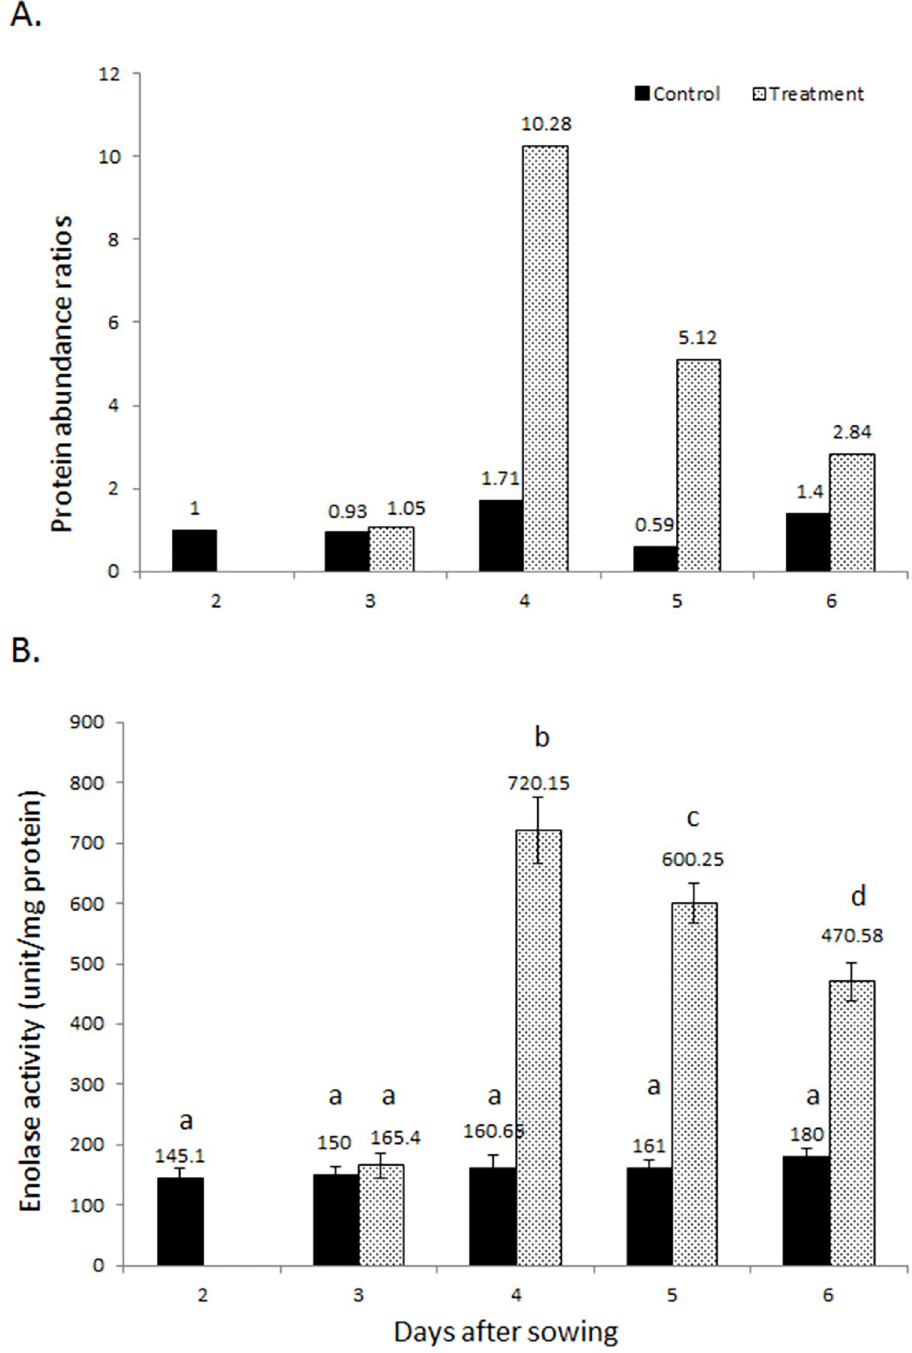
Fig 6. Changes in protein abundance (A) and enzyme activity (B) of enolase in soybean roots under flooding stress. Different alphabets indicate significant changes as determined through One-way ANOVA and Duncan’s multiple range